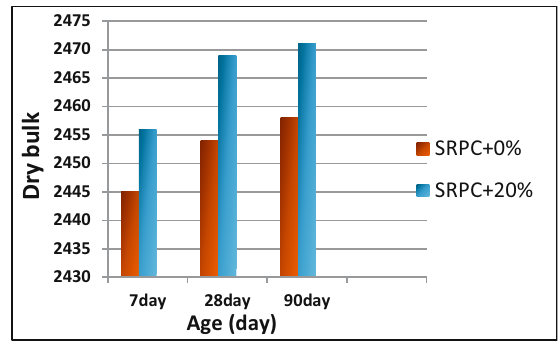
Figure 5: Relationship between compressive strength ( MPa ) and age ( day ) for SRPC.